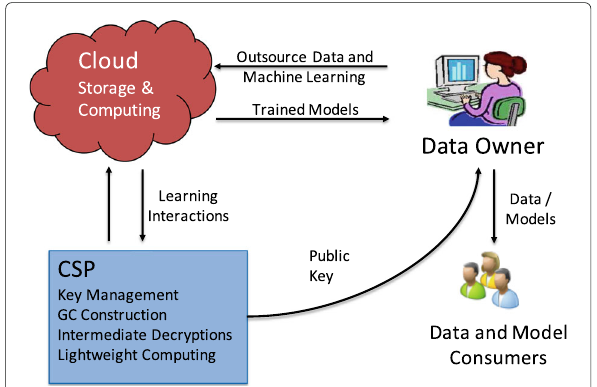
Fig. 2 A data owner outsources data storage and machine learning tasks to the Cloud. The Cryptographic Service Provider (CSP) manages the keys, decrypts intermediate results, and assists the Cloud with other relatively lightweight